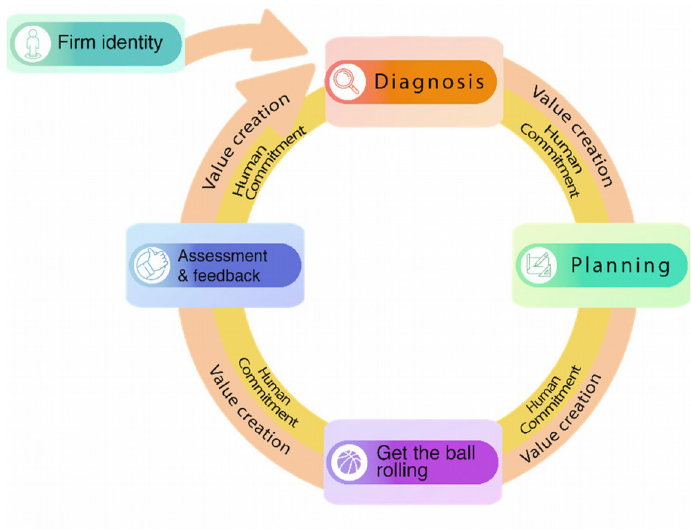
Figure 2. The Ecopyme as a strategic methodology for implementing the CE in